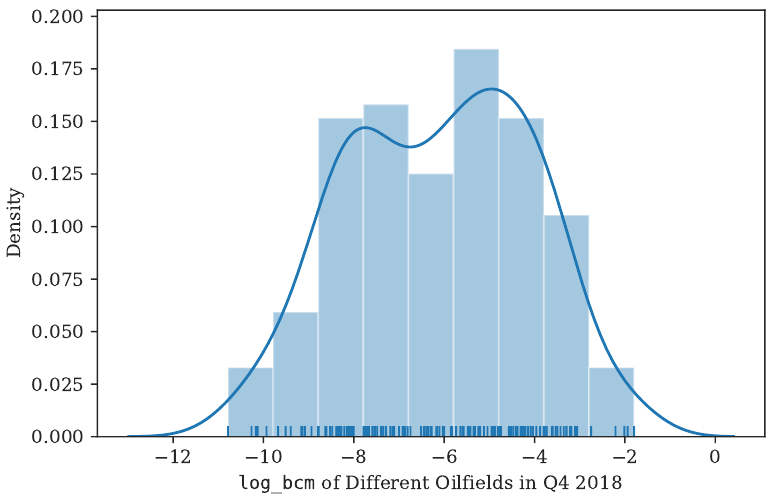
Figure 20. Distribution of the field flared volume magnitudes from the fourth quarter of 2018. The rug plot labels the value for each field. The curve displays a Gaussian